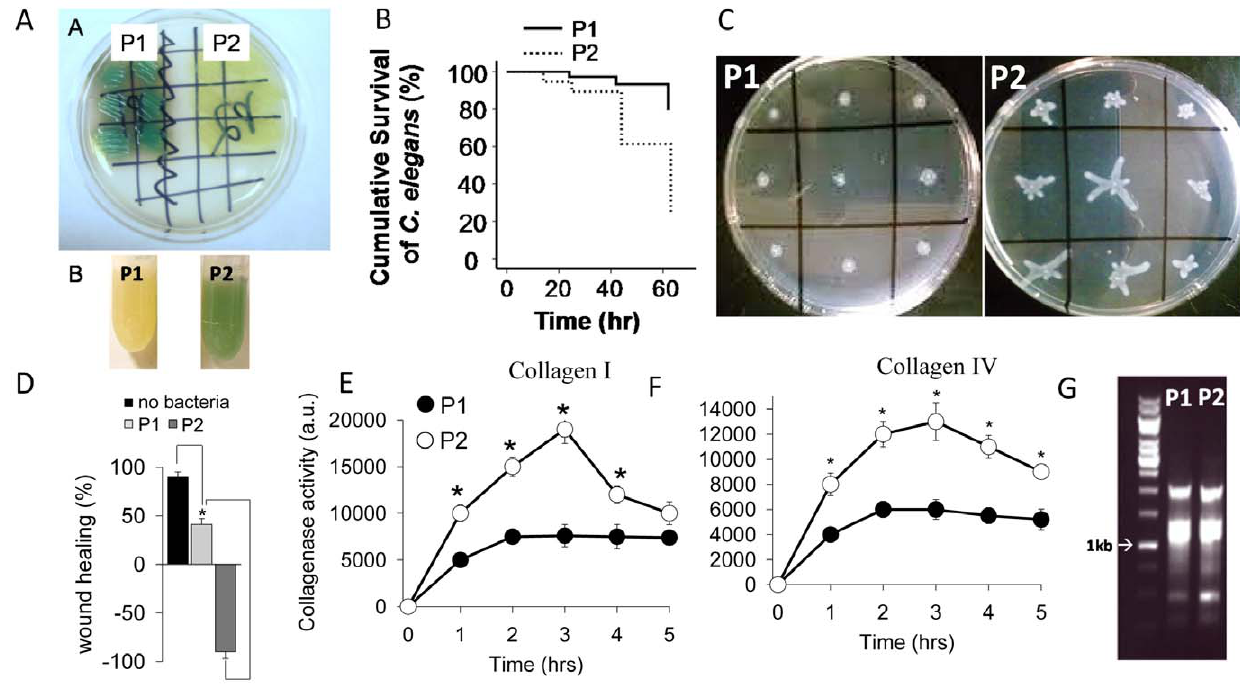
Figure 3. P1 and P2 phenotypes of P.aeruginosa MPAO1. (A) Pyocyanin production seen as green color pigmentation on solid PIA and liquid TSB media. (B) Kaplan-Meyer survival curves of C. elegans N2 feeding on P1 and P2. Cumulative survival is represented of 2 experiments, n=7/dish, 5 dishes/experiment, p , 0.01. (C) Swarming motility. (D) Wound healing assay. Wound width was calibrated and measured using the MicroSuite software for imaging applications (Olympus SZX16). Wound healing of 2 100% indicates a 2 fold increase in the wound width compared to the baseline width. n=12, *p , 0.01. (E,F) Collagenase activity of P1 and P2 measured by degradation of fluorescent labeled collagen I (E) and collagen IV (F) as substrates. n=6, *p , 0.01. Fluorescence values were normalized to cell density measured by absorbance at 600 nm. Results are representative of 3 independent experiments. (G) RAPD fingerprint analysis demonstrating a similar genetic background of the P1 and P2 phenotype strains.